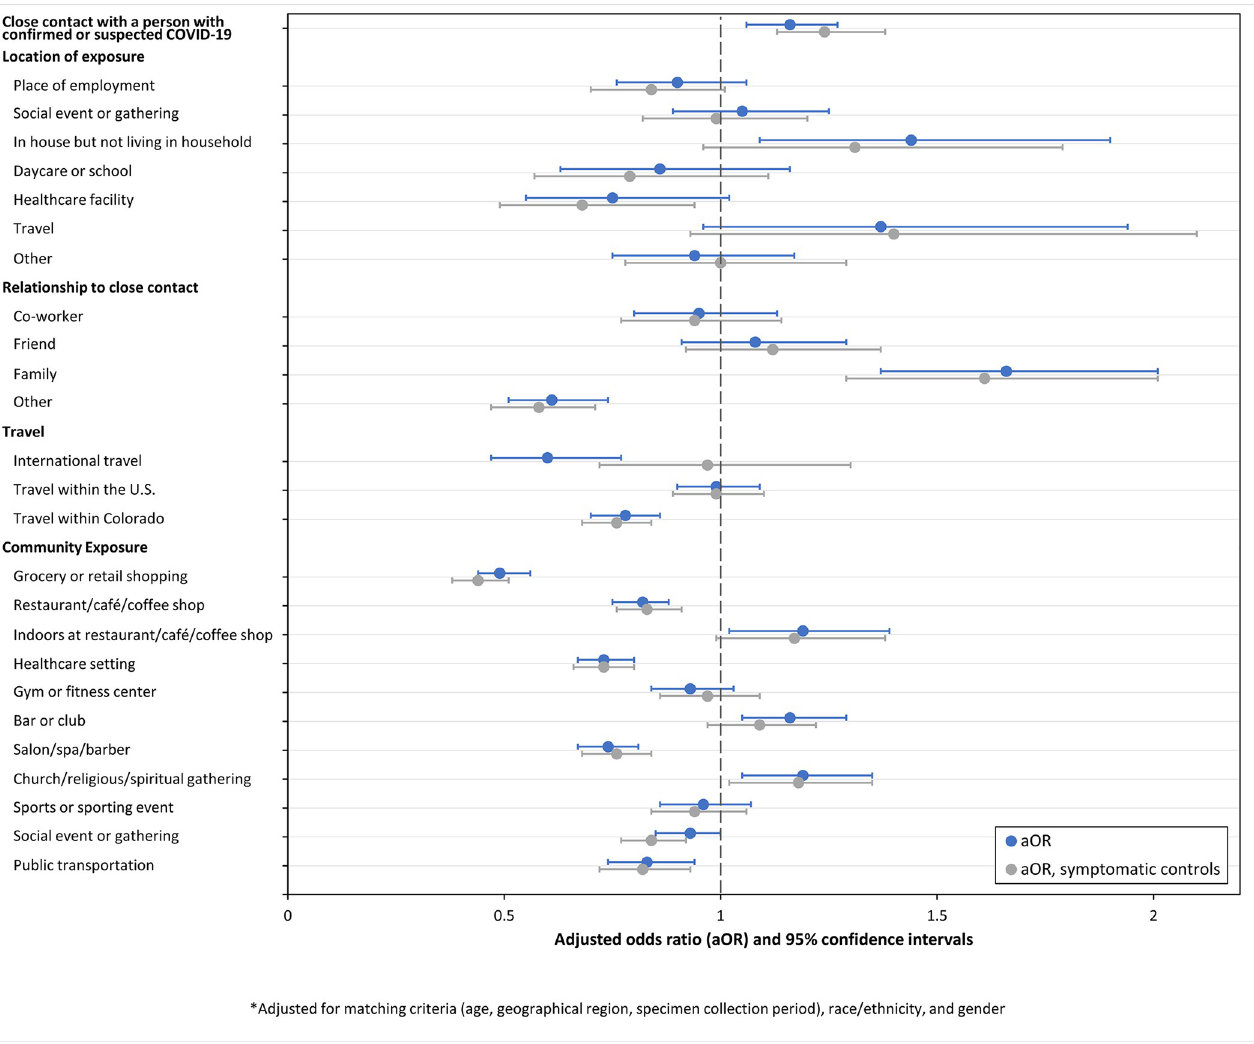
Fig 3. Adjusted odds ratio (aOR) � and 95% confidence intervals for exposures associated with confirmed COVID-19 among symptomatic Colorado adults aged � 18 years–specimen collection dates from March 16 to December 23, 2021. � Adjusted for matching criteria (age, geographical region, specimen collection period), race/ethnicity, and